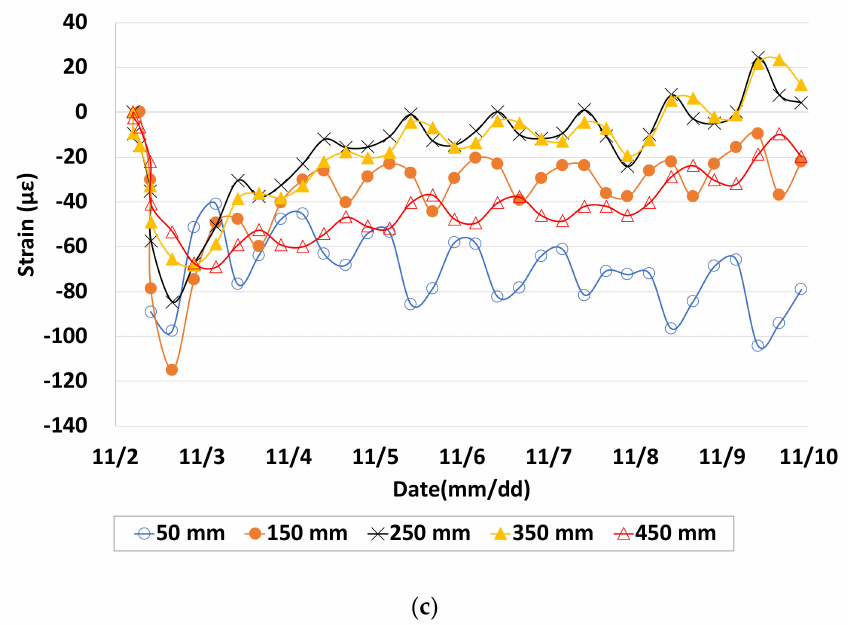
Figure 14. Shrinkage strain according to the slab depth for the first seven days: ( a ) corner, ( b ) mid-edge, and ( c ) center.